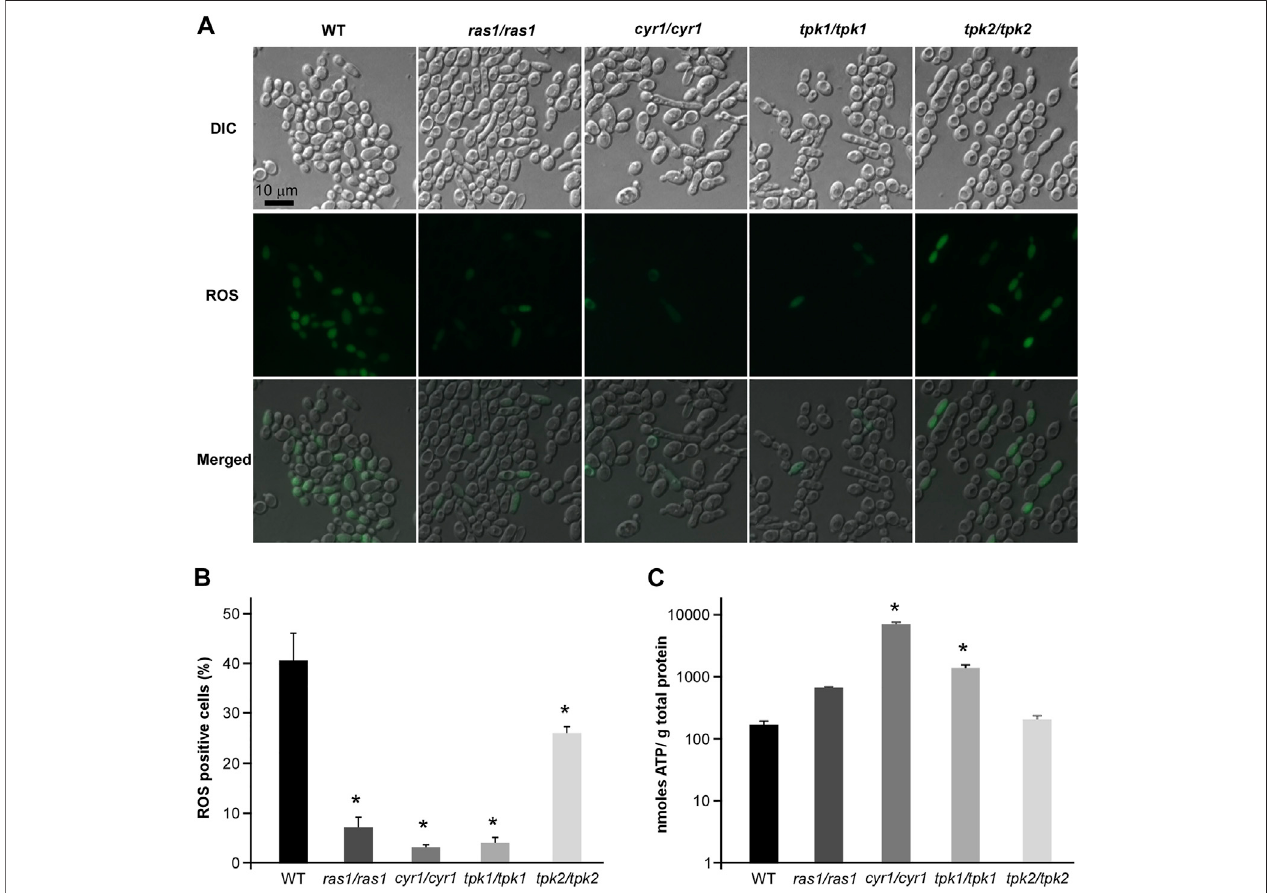
FIGURE 8 | The regulatory role of cAMP-PKA pathway in ROS accumulation and ATP consumption in CHGX water-extract-induced cell death of C. albicnas . StrainsusedweretheWT(SN152),and ras1/ras1 , cyr1/cyr1 , tpk1/tpk1 , tpk2/tpk2 , tpk1/tpk1tpk2/tpk2 mutants. (A) TheintracellularROSproductioninWTandmutant strains.Fungalcells(2×10 6 cells/ml)weretreatedwith20 mg/mlCHGXwater-extractinLee ’ sglucosemediumfor3 hat30 ° C.Cellswereharvestedandincubatedwith DCFH-DA for fl uorescence microscopy. (B) The percentage of ROS-positive cells. The values were expressed as mean ± SD of three independent experiments according to fl uorescence microscopy in panel A. (C) The intracellular ATP level in WT strain and mutants. Fungal cells (2 × 10 6 cells/ml) were treated with 20 mg/ml GHGXwater-extract inLee ’ sglucosemediumfor2 hat30 ° C.Cellswereharvestedandhomogenizedwith1×PBSforATPassaybyanATPBioluminescenceAssaykit. Threebiologicalrepeatswereperformed,andthevaluesarepresentedasmean±SD.One-wayanalysisofvariance(ANOVA)wasusedtocomparedifferencesbetween WT and mutant strains as indicated in panels B and C; *, p <